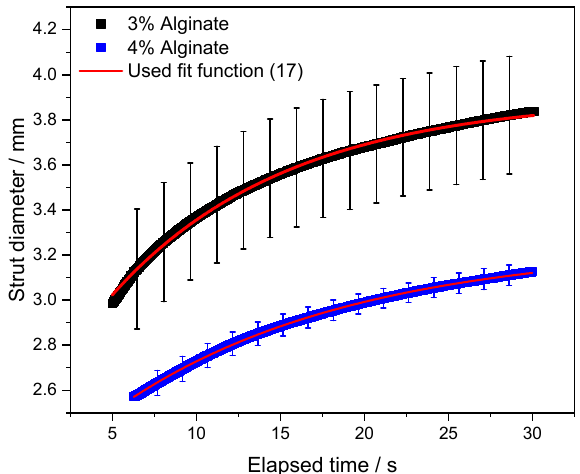
Figure 7. Time dependent strut diameter of 3% and 4% alginate solutions.